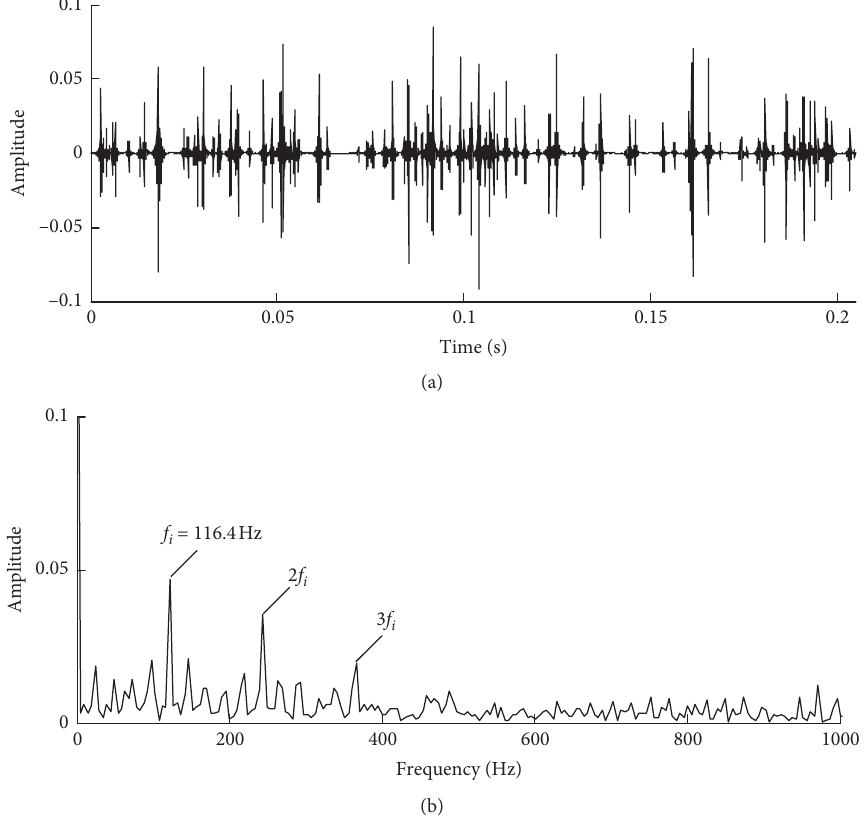
Figure 16: Fault signal and envelope spectrum of inner race after